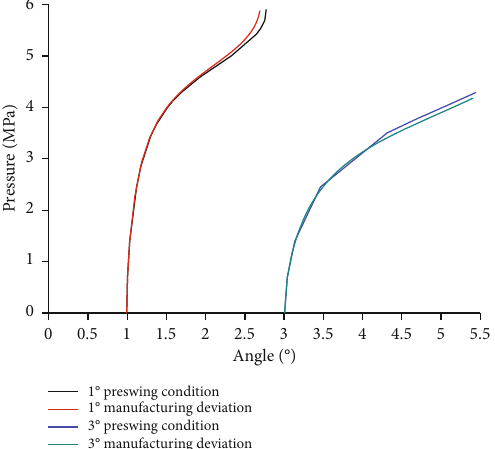
Figure 11: The in fl uence of pre-swing and manufacturing deviation on swing angle.